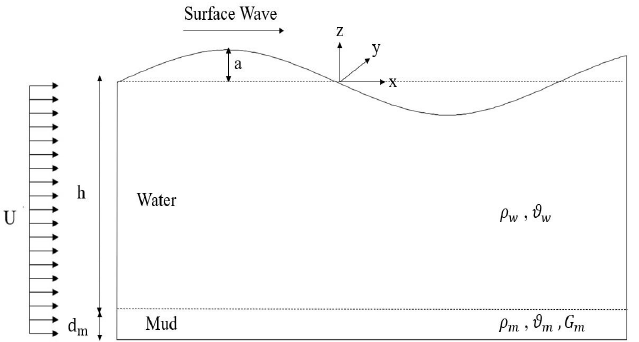
Figure 1. Definition sketch for wave-current-mud interaction in a two-layer